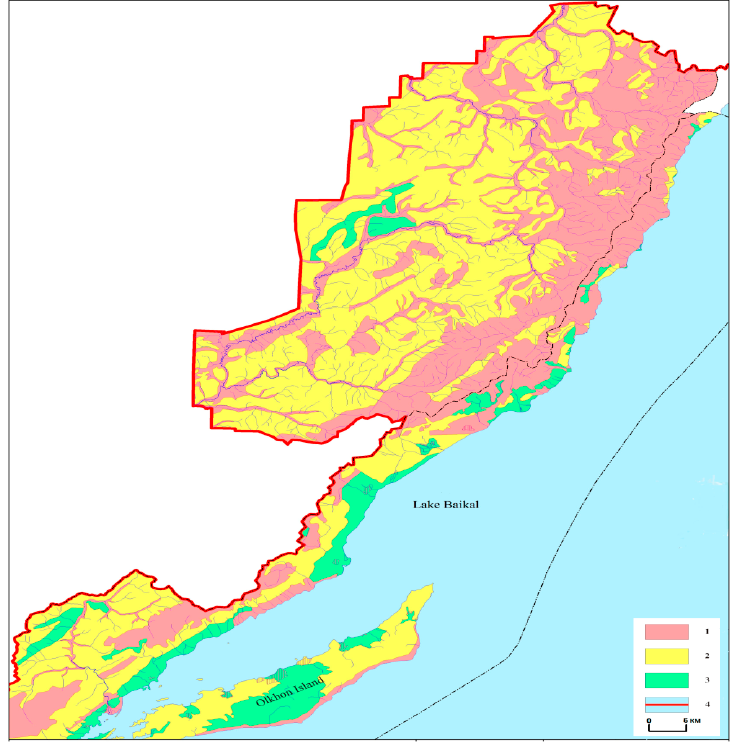
Figure 3. Functional zoning of part of the central ecological zone of the Baikal Natural Territory. Zones: 1—preservation of current condition; 2—regulated use; 3—development; 4—boundary of the central ecological zone.